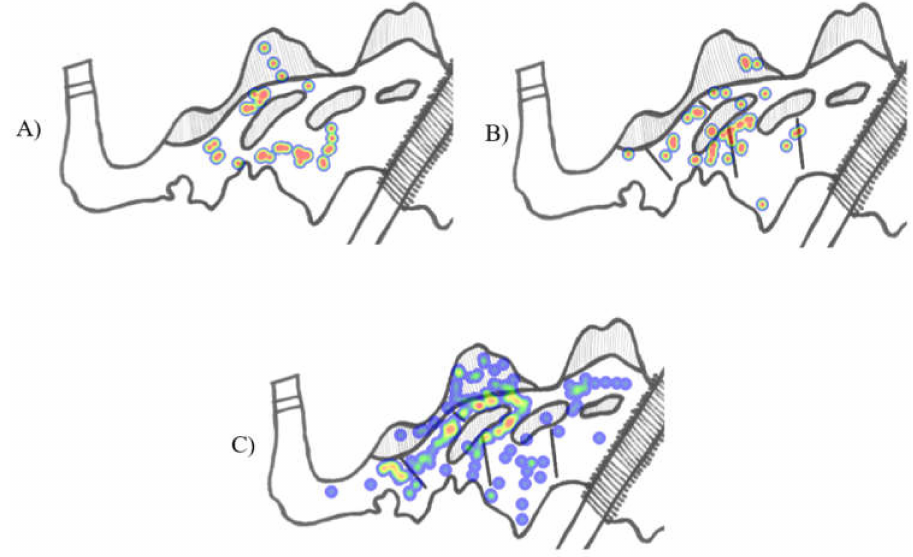
Figure 3. ( A ) Heatmap depicting the locations of agonistic interactions observed during the short-term pre-visual barrier observation period. ( B ) Heatmap depicting the locations of agonistic interactions observed during the short-term post-visual-barrier observation period. ( C ) Heatmap depicting the locations of agonistic interactions observed during the long-term post-visual-barrier observation period. Note: data for long-term pre-visual barrier observation period were not recorded in a visual format. All heatmaps generated using the ZooMonitor application [38]. Locations highlighted in red are more-frequent locations of agonism. Locations highlighted in green and dark blue are less-frequent locations of